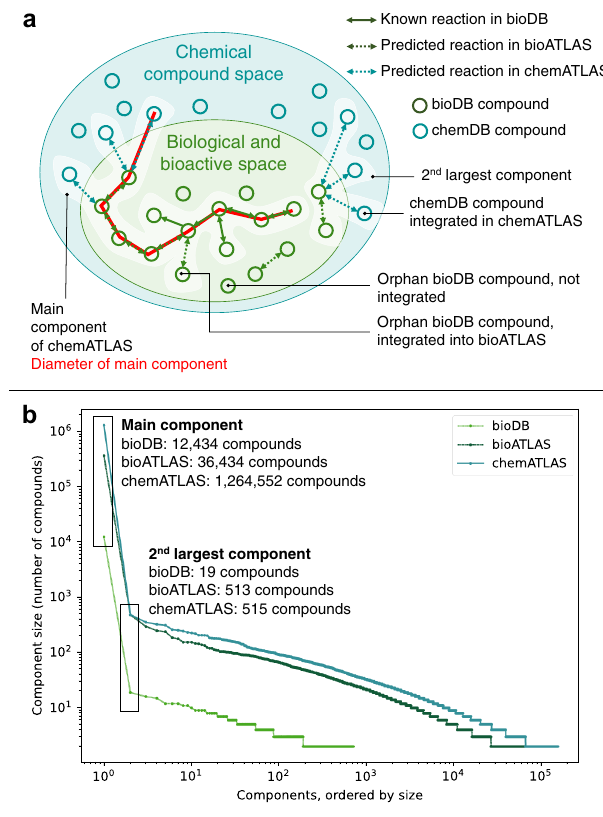
Fig. 2 Graph-theoretical analysis of biotransformation networks. a Schematic overview of statistics and network properties calculated for bioDB, bioATLAS, and chemATLAS. Reactions exclusively involving biological and bioactive compounds (green nodes) are assigned to the bioATLAS reaction space, and reactions involving one or more chemical compound (light blue nodes) are assigned to the chemATLAS reaction space. The main component and the second largest component of the network are schematically shown (white highlight). The diameter, or longest shortest path between any two nodes of the main component, has a length of 8 and is highlighted in red. b The components of each reaction scope in ATLASx have been extracted and ordered by size. Here, the number of compounds (nodes) of each component is plotted on a log-log scale to show the size distribution of disconnected components for bioDB, bioATLAS, and chemATLAS. For the main component (highest number of nodes) as well as for the second largest component, exact numbers of compounds are